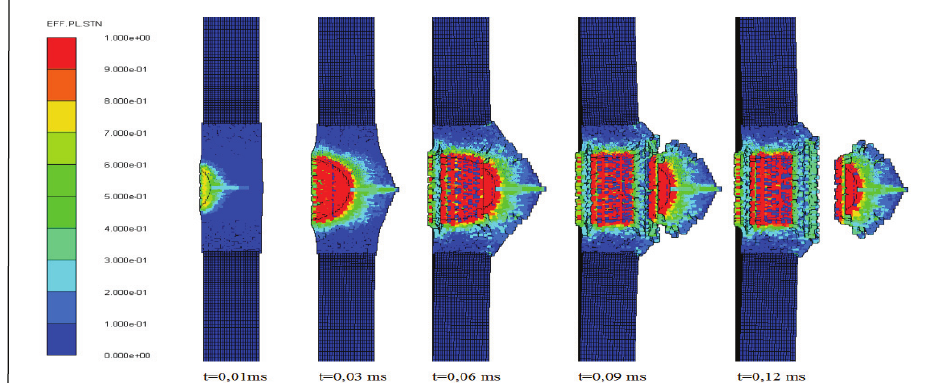
Figure 32 – Perforation of a 12 mm thick steel plate, hemispherical projectile (SFM